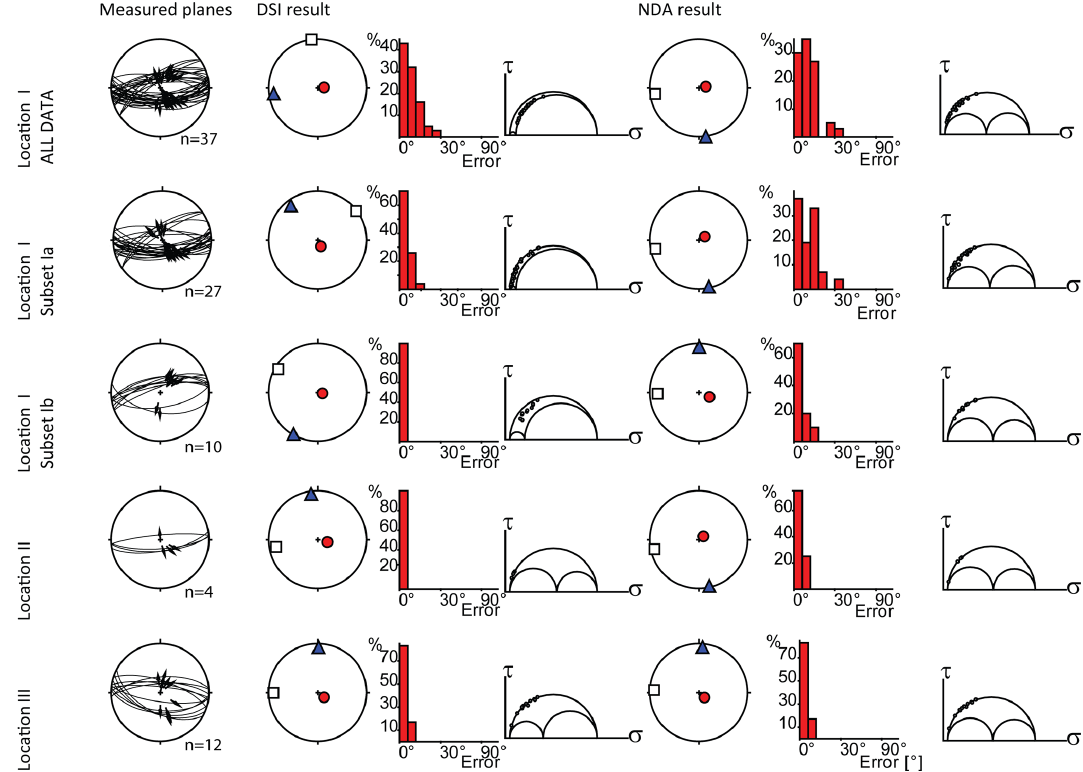
Figure 7. Fault plane orientation–slip direction and palaeostress (DSI) and palaeostrain (NDA) results from locations I to III along Segments B and C. No palaeostress results are shown for location IV, as the number of observations here was too low to obtain a valid